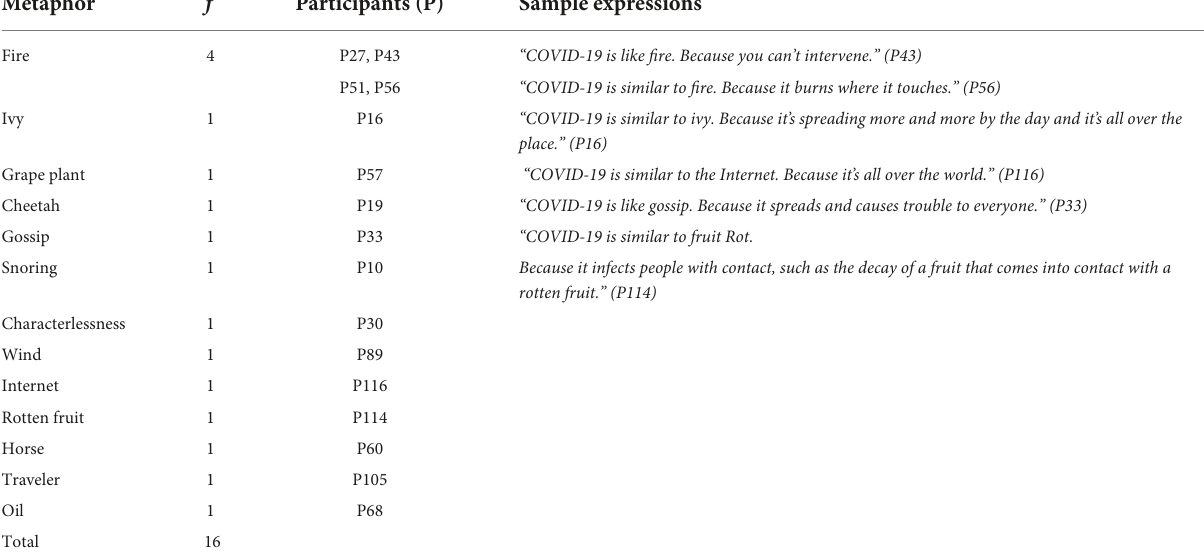
TABLE 7 Fast spanning category.